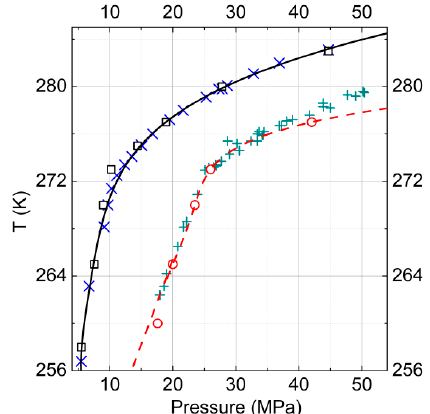
Figure 4. P - T diagram of gas–hydrate–ice (water) phase equilibria for one-component hydrates of carbon dioxide and methane. The results of the calculations for carbon dioxide are represented by the open squares, and the experimental data [6] by the skew crosses. For methane, the calculated data are shown by open circles and the experimental data [6] by crosses .